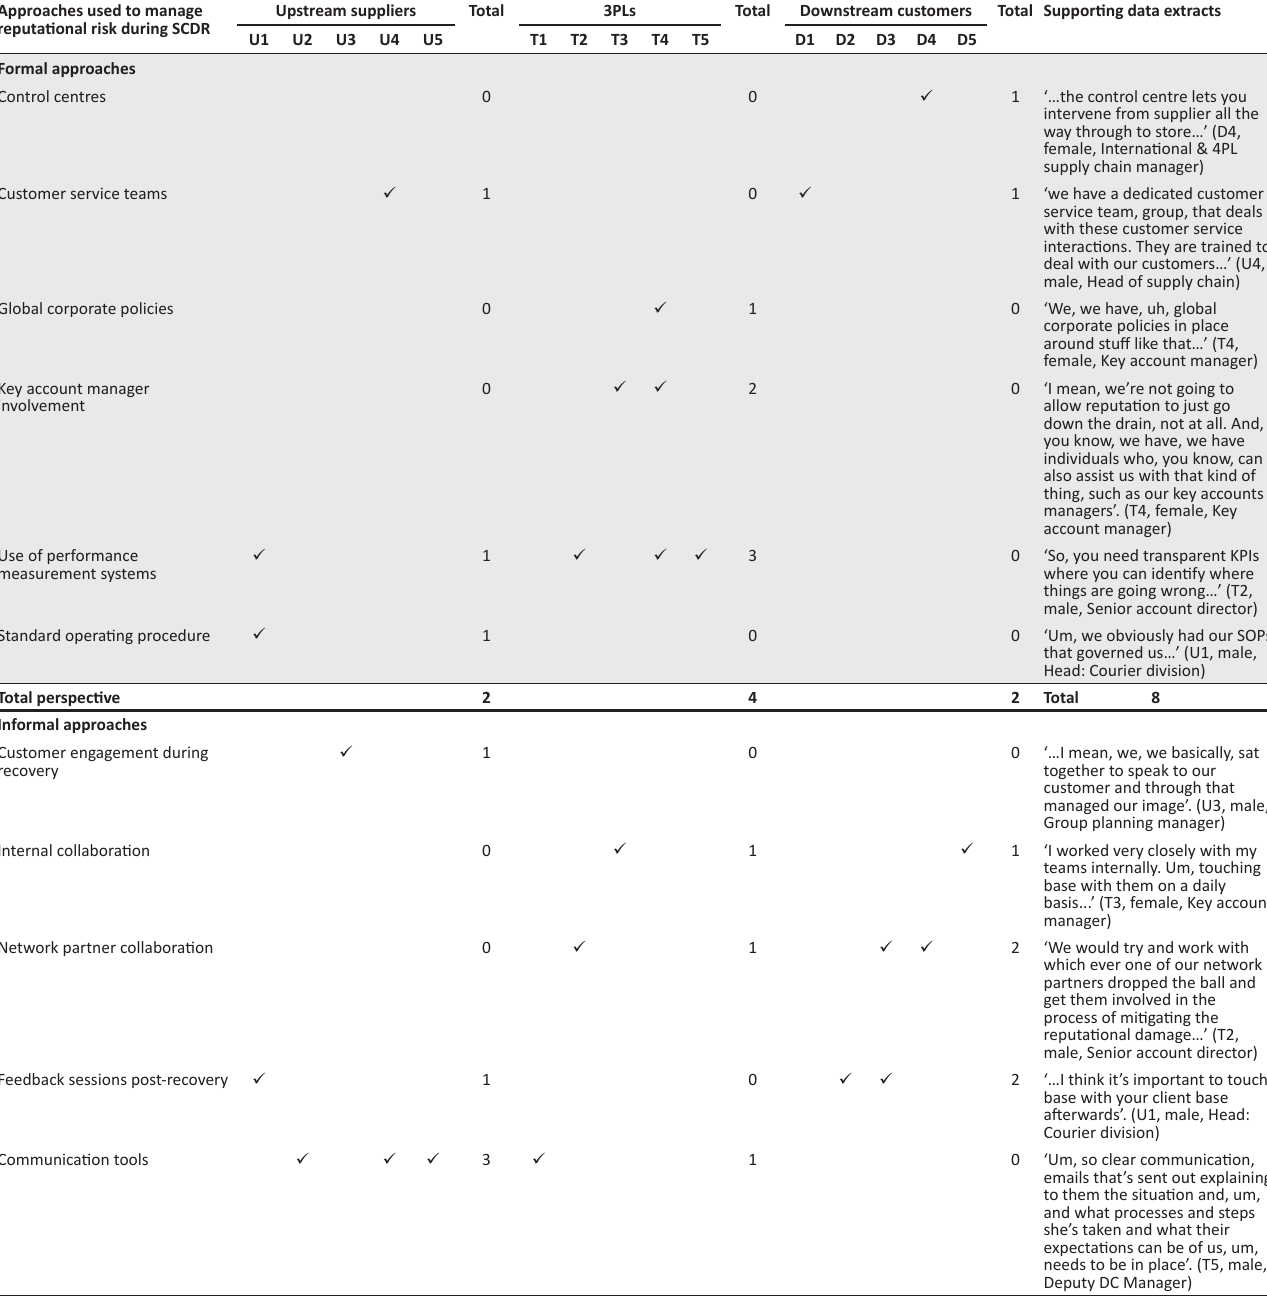
TABLE 3: Reputational risk management approaches used during supply chain disruption recovery. Approaches used to manage reputational risk during